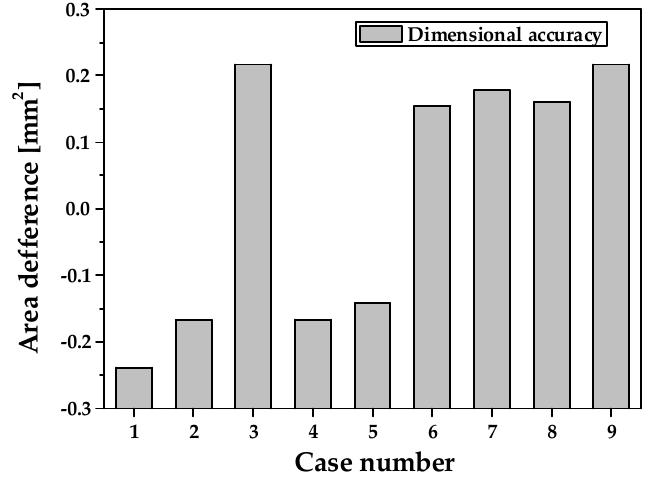
Figure 5. Results of the FE simulation for dimensional